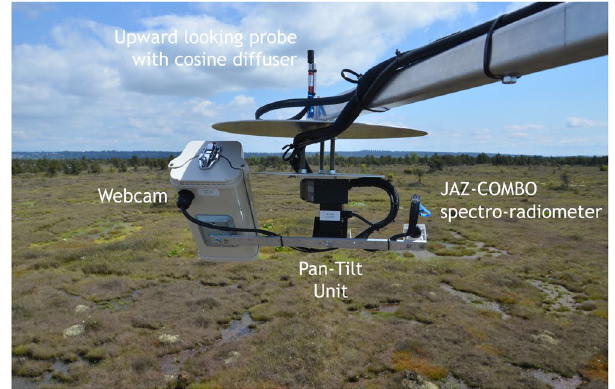
Figure 2. In-situ photograph of the AMSPEC-III system taken at the Burns Bog flux tower (Ca-DBB). In the figure the system faces approximately 90°E.